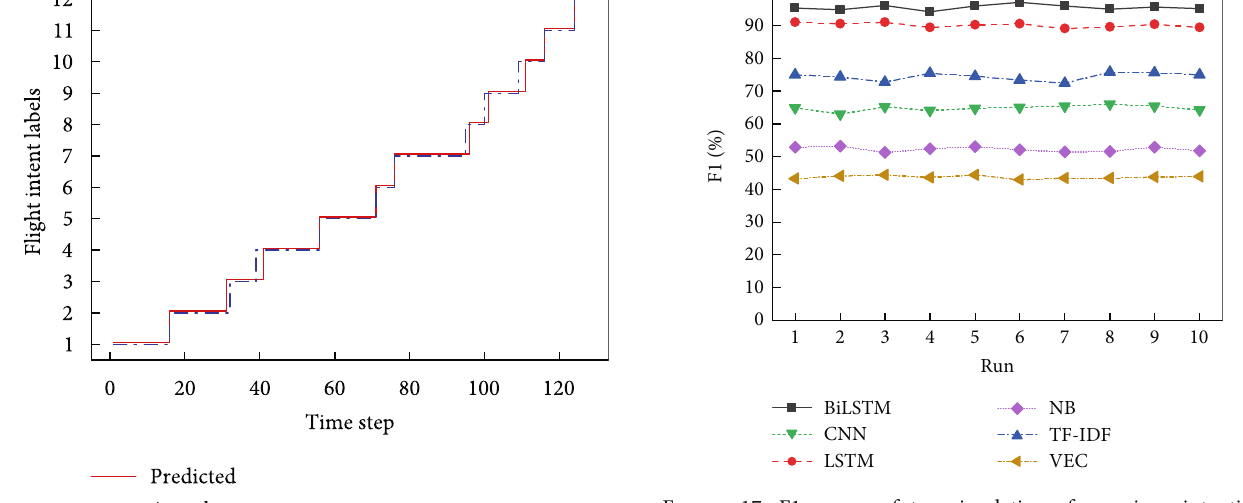
Figure 17: F1 scores of ten simulations for various intention modeling methods.